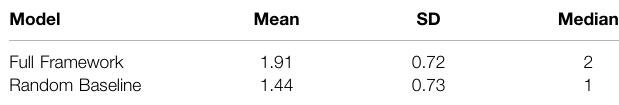
TABLE 1 | Amazon mechanical turk